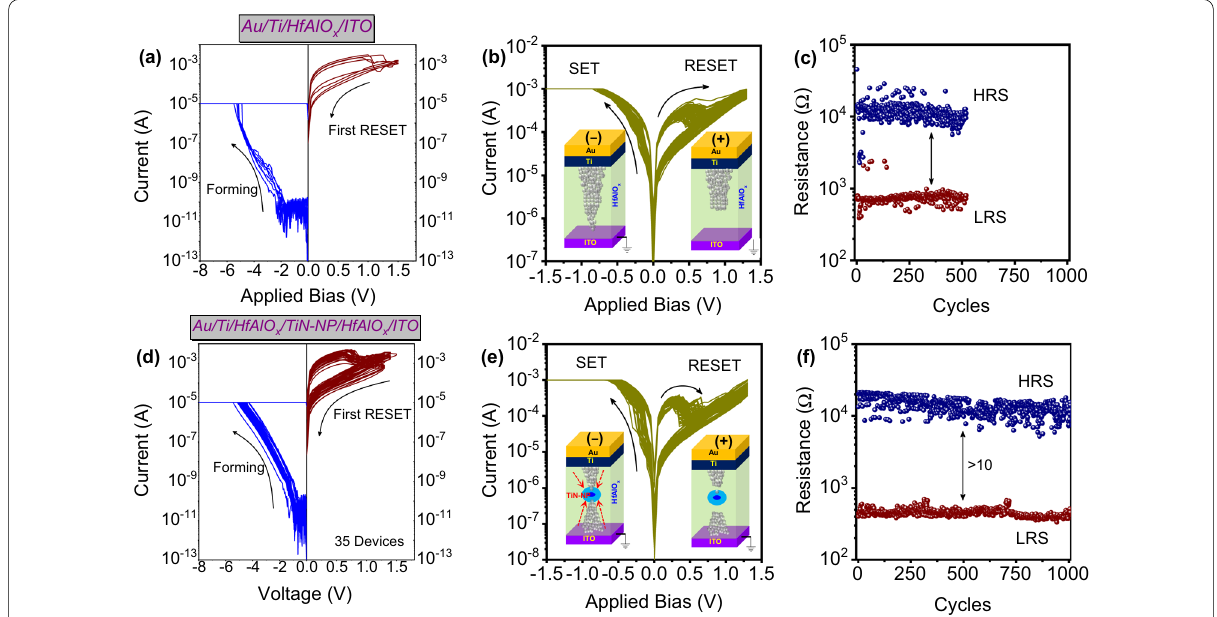
Fig. 2 a , d Electroforming at 10 µA I cc and 1 st RESET characteristics of multiple Au/Ti/HfAlO x /ITO and Au/Ti/HfAlO x /TiN-NP/HfAlO x /ITO RRAM devices. b , e Bipolar resistive switching properties with SET at 1 mA I cc for both devices. Inset shows the schematics of switching mechanism during SET/RESET operations. c , f Endurance behavior of both Au/Ti/HfAlO x /ITO and Au/Ti/HfAlO x /TiN-NP/HfAlO x /ITO RRAM devices with 500 and 1000 DC cycles,